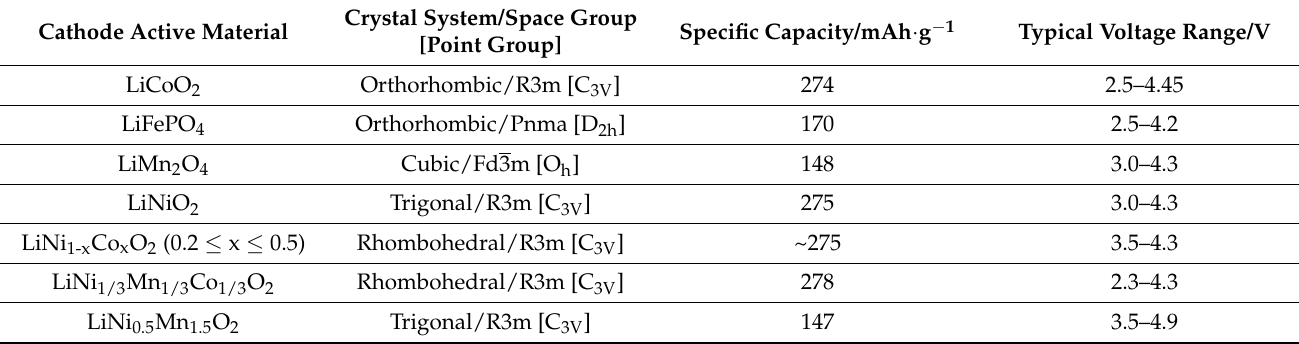
Table 2. Most commonly active cathode active materials used for lithium-ion battery applications [130]. Crystal System/Space Group Cathode Active Material [Point